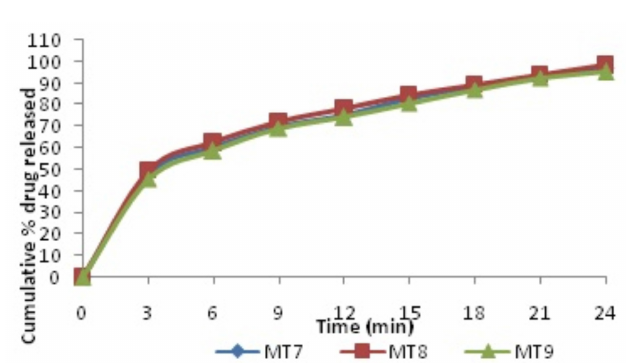
FIGURE 10 - In vitro release of metoprolol tartrate from tablets of MT7 to